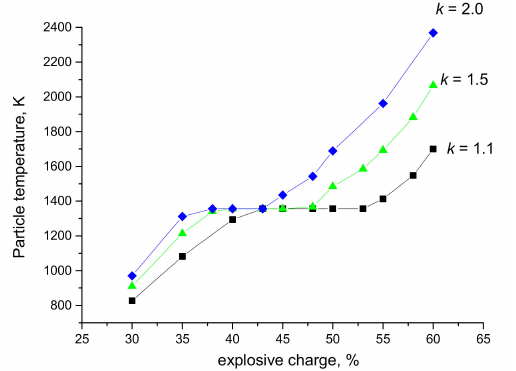
Figure 4. Detonation splats formed from nickel particles at di ff erent temperature–velocity combinations (calculated values): ( a ) 360 m s − 1 , 1450 K; ( b ) 420 m s − 1 , 1700 K and ( c ) 460 m s − 1 , 2200 K. The substrate material is steel. These samples were obtained in a study reported in Ref. [19].